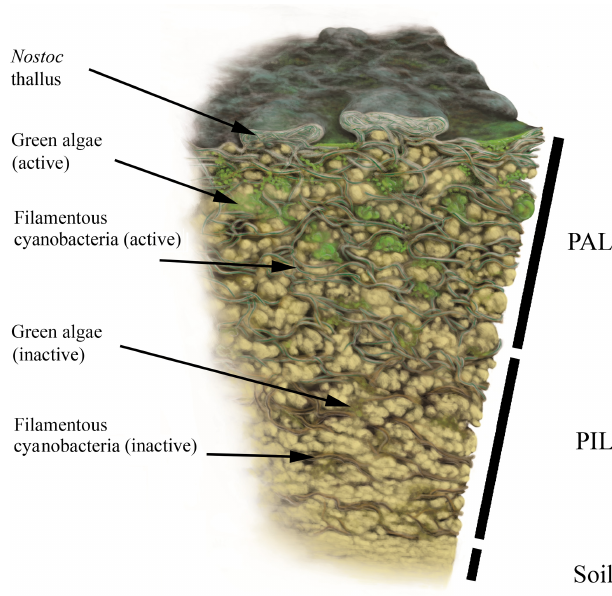
Figure 3. Biomap scheme. Simplified illustration of a vertical BSC cross section with photosynthetic active cyanobacteria and green al- gae in the PAL (photosynthetic active layer) stratum as well as both fractions in their dead or inactive forms within the PIL (photosyn- thetic inactive layer) stratum. Illustration by Frederik